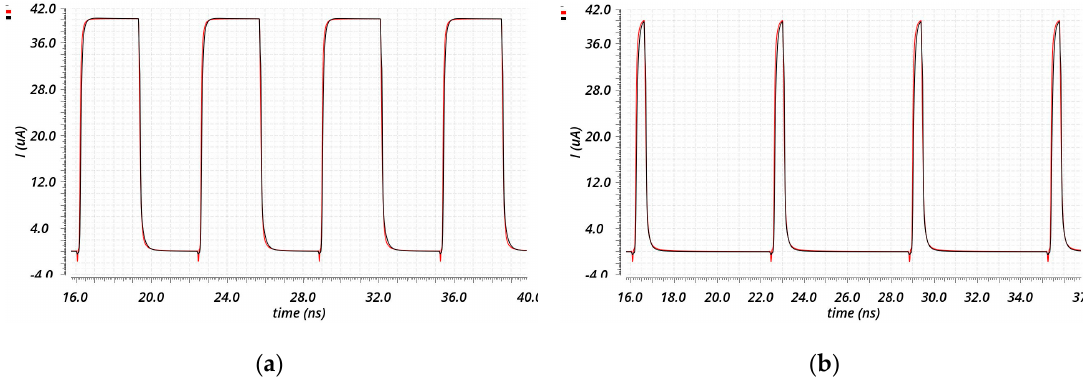
Figure 12. Transient behavior of the CP of Figure 11. The source current is in red and the sink current is in black for two different values of ON time of the input signals (UP_P-UP_N and DW_P-DW_N): ( a ) 3.2 ns, ( b ) 500 ps.